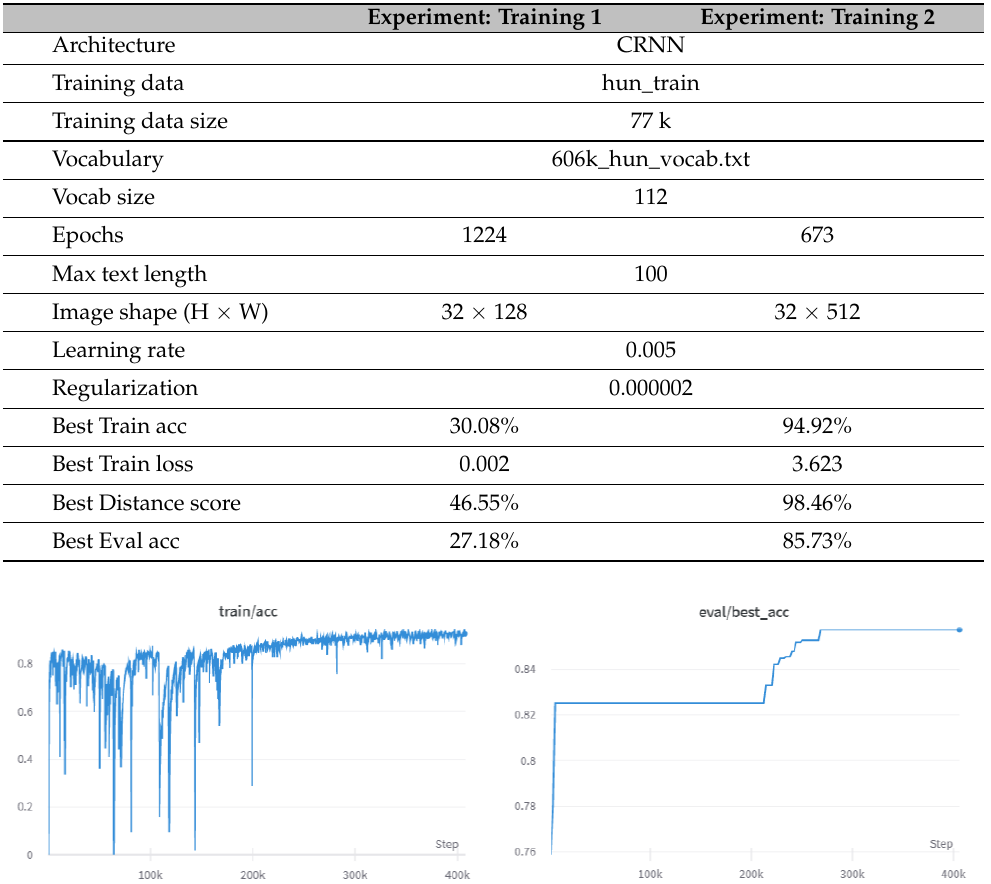
Table 7. Hungarian with parameter checking.